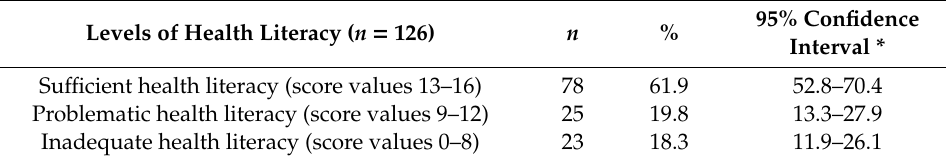
Table 3. Relative frequency of HLS-EU-Q16 levels (defined according to [20]).